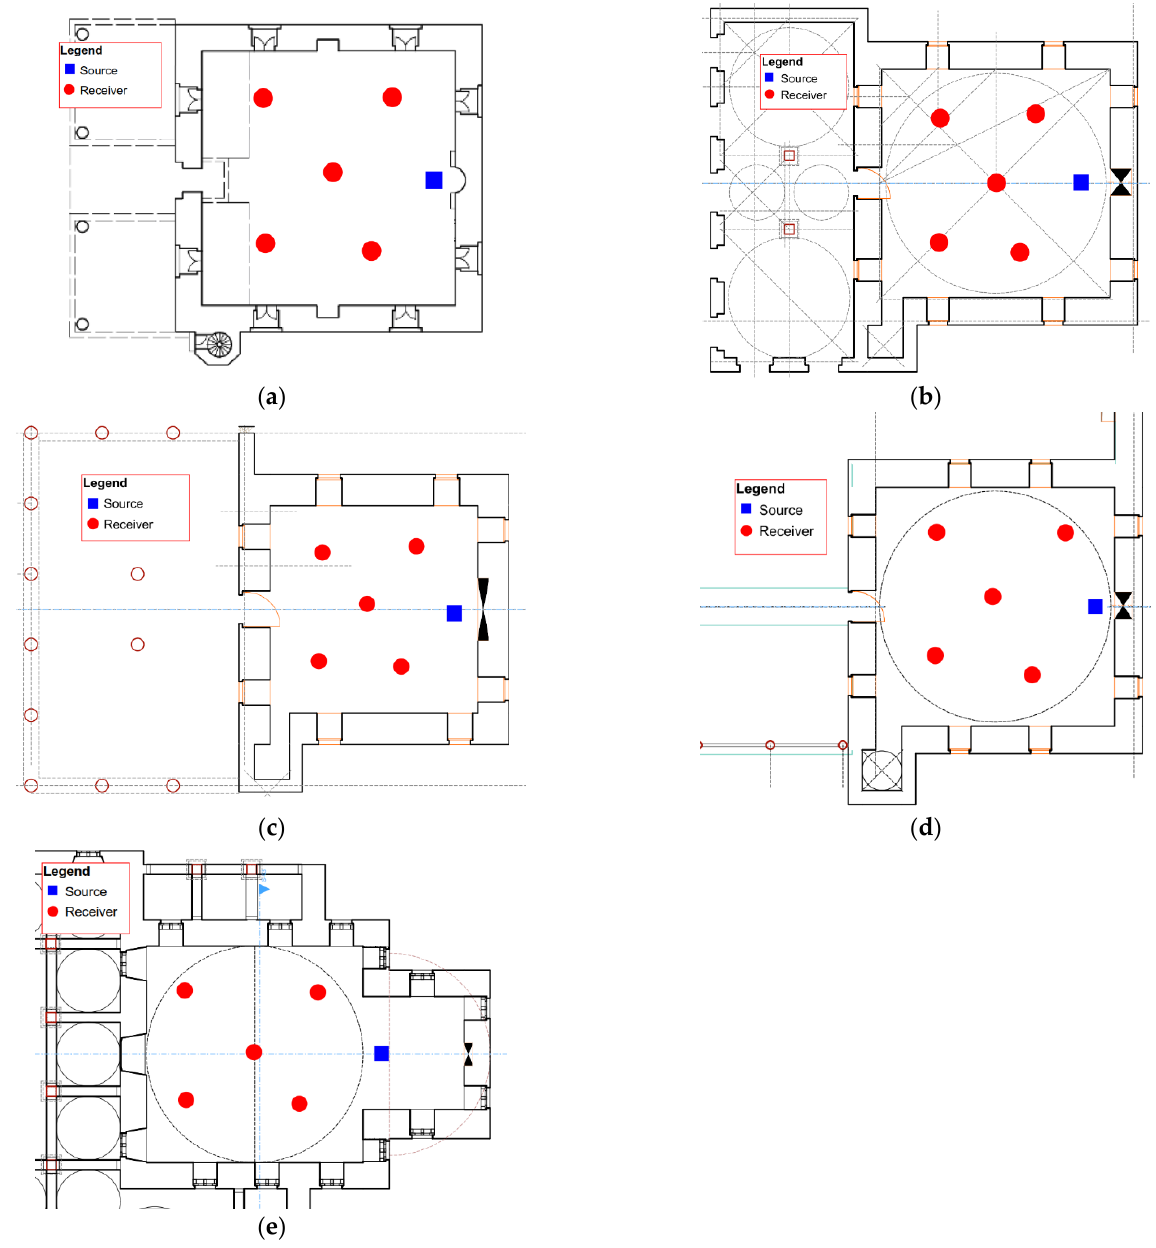
Figure 14. Scheme of the equipment location during the acoustic surveys inside the selected mosques: Naziresha in Elbasan ( a ), Lead in Berat ( b ), Kabalie in Kavaja ( c ), Et’hem Bey in Tirana ( d ), Lead in Shkodra ( e ).